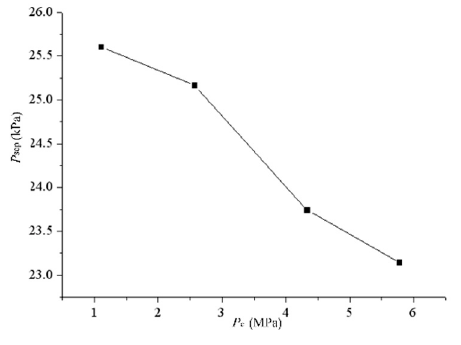
Figure 15. The pressure at the separation point varies with the total inlet pressures.